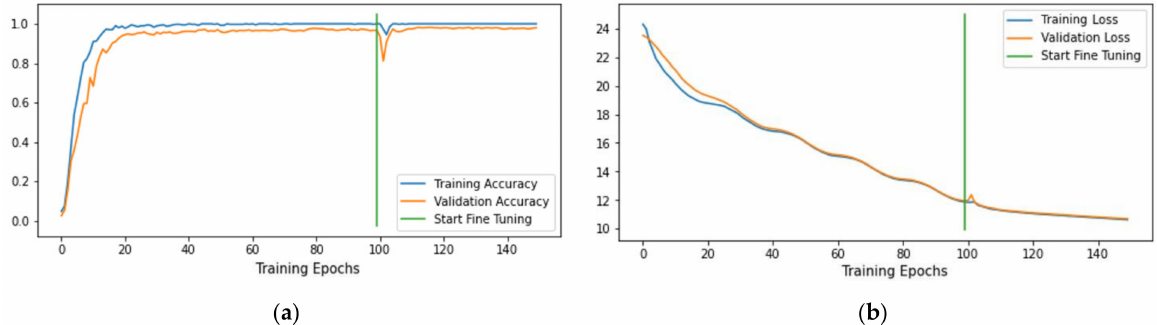
Figure 12. Model training history of WHU-RS19 dataset: ( a ) training and validation accuracy; ( b ) training and valida- tion